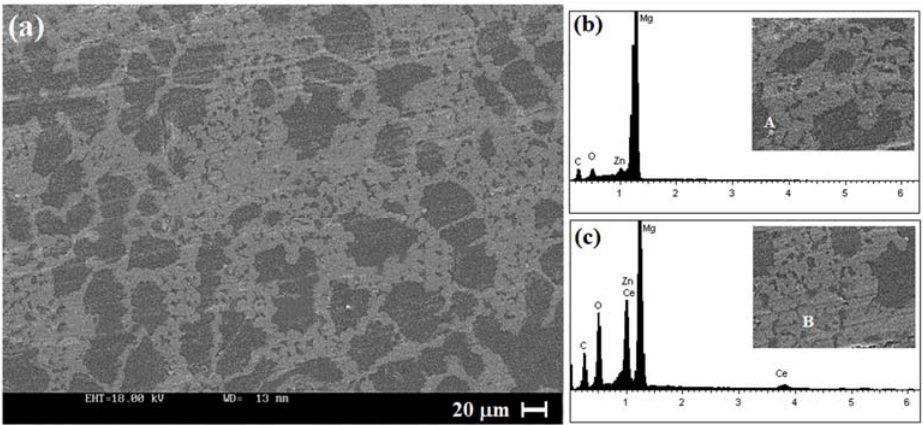
Figure 2. ( a ) Scanning Electron Microscope (SEM) micrographs of Mg-Zn-Ce alloy, and Energy Dispersive X-ray Spectroscopy (EDX) analysis of ( b ) area A and ( c ) area B.